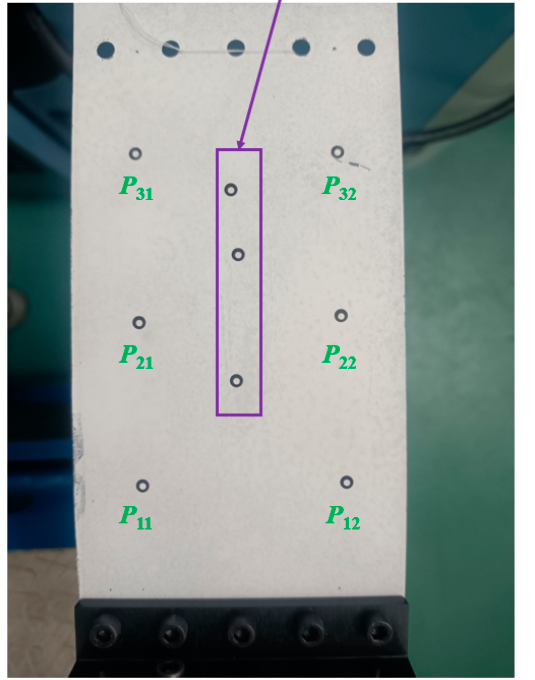
Figure 16. The FLS in the experiment.